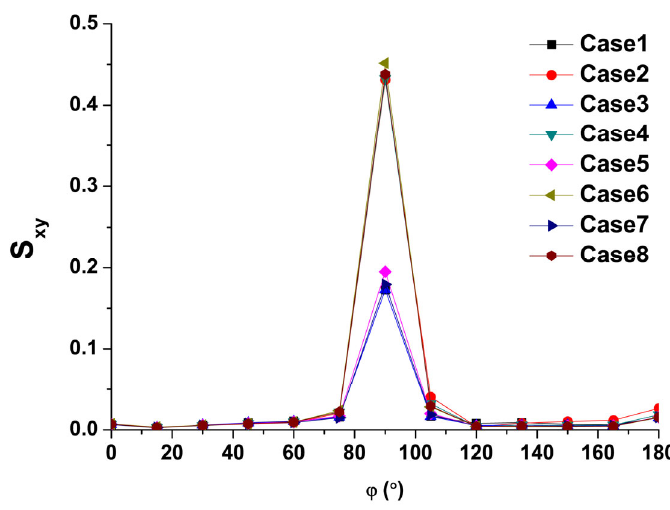
Figure 15. Secondary flow strength ( 𝑆 (cid:3051)(cid:3052) (cid:4667) along the curved reach in the main